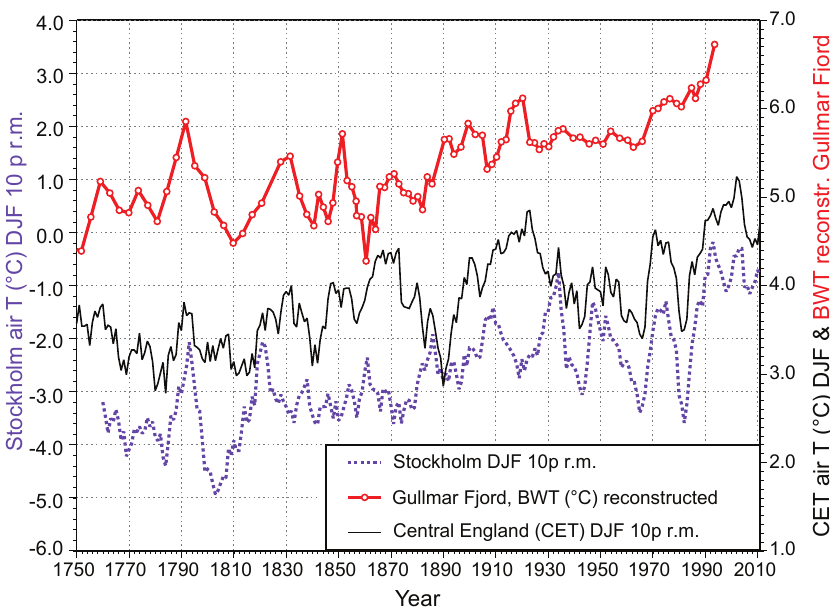
Figure 8. Comparison of reconstructed winter bottom water temperatures (BWT) from Gullmar Fjord to meteorological observations of winter air temperatures recorded for Stockholm (stippled line) and central England (solid line without